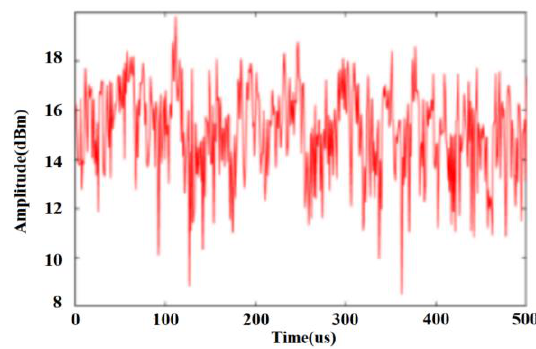
Figure 12. Ground clutter modeling method used to generate the Weibull distribution time domain signal.